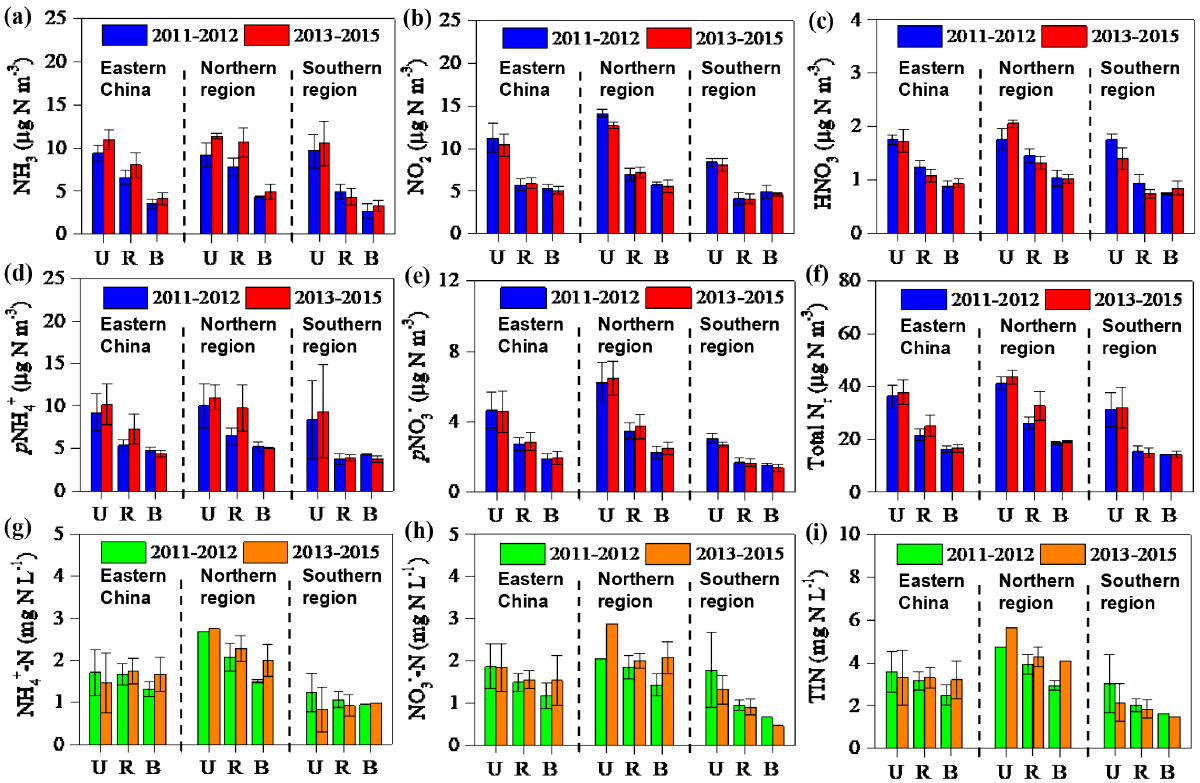
Figure 2. Comparison of annual mean concentrations of (a) NH 3 , (b) NO 2 , (c) HNO 3 , (d) p NH + of all measured N r in air; volume-weighted concentrations of NH + precipitation between the 2011–2012 period and the 2013–2015 period for different land use types in eastern China and its northern and southern regions. U, R, and B denote urban, rural, and background sites respectively. The number of sites for each land use type in each region can be found in Table S1 in the Supplement. The error bars are the standard errors of